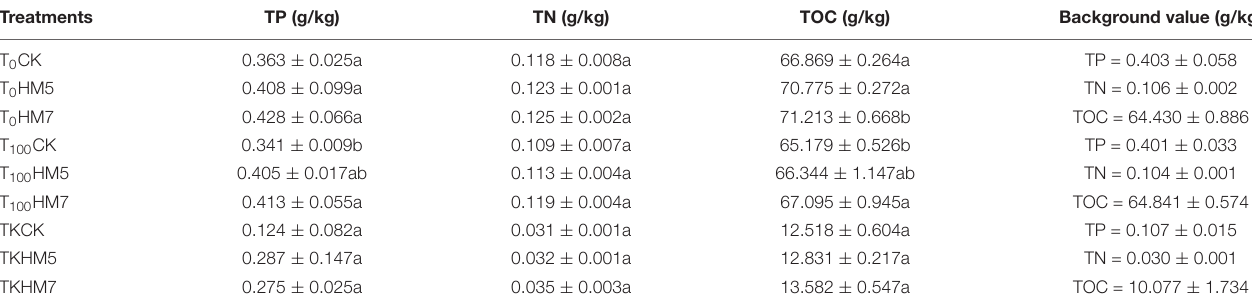
TABLE 1 | Physicochemical properties of treated soil and slag.